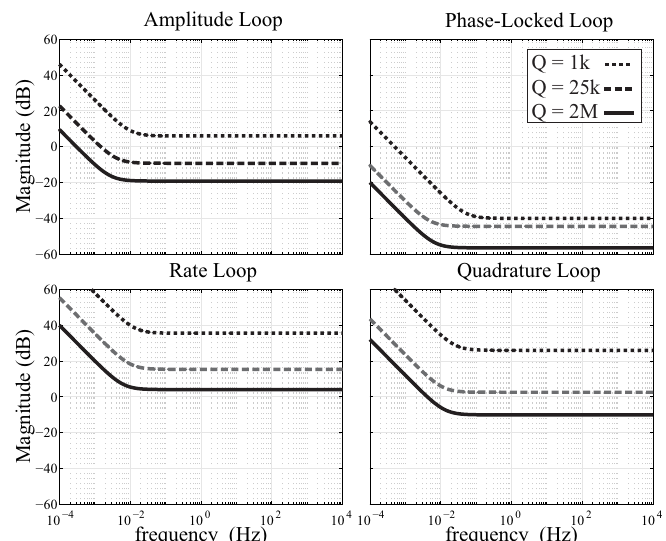
Figure 14. Illustrated configurations of PI parameters on the amplitude (AGC), phase (PLL), quadra- ture (QCL) and rate (RCL) loops for QMG devices with Q-factors ranging from 1000 to 2,000,000. PI parameters were scaled proportionally to the Q-factor of the device. Results are